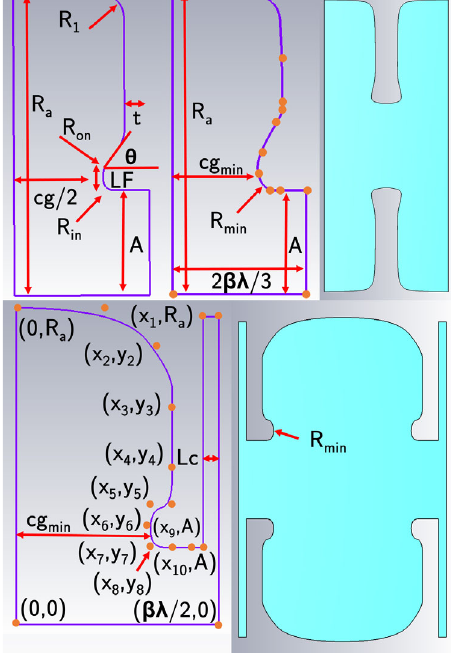
FIG. 3. Standard and spline geometries for the X-band traveling wave cavity (top) and the C-band standing wave cavity (bottom), showing input parameters.